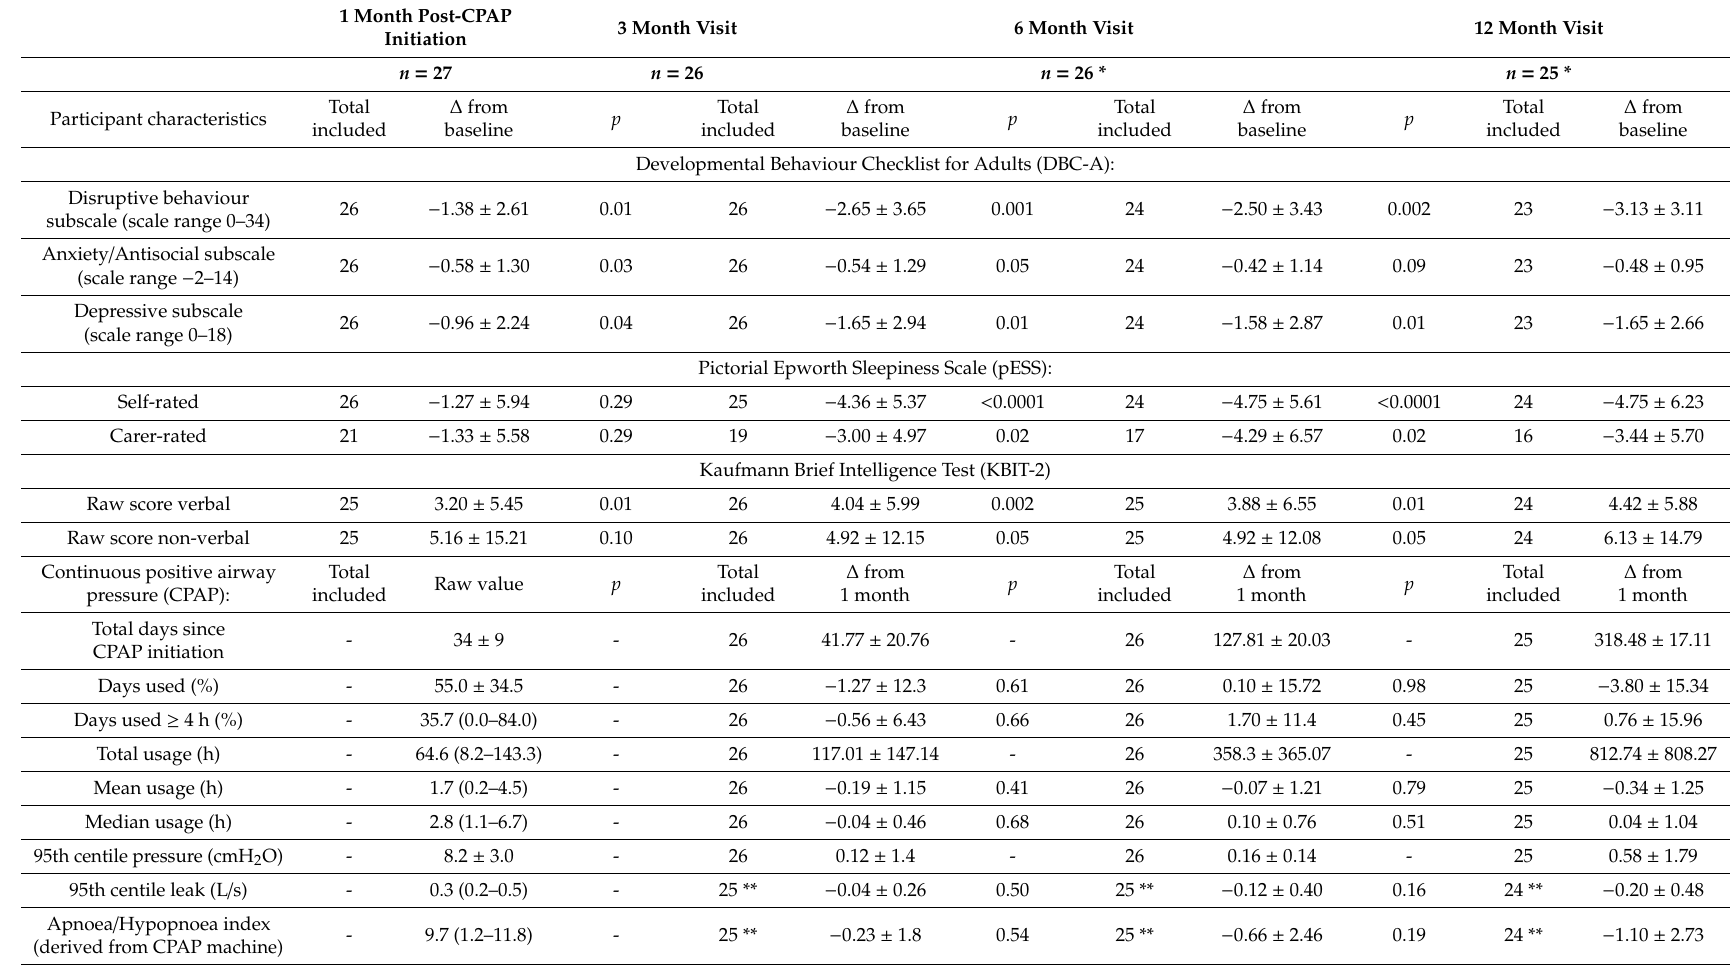
Table 3. Change ( ∆ ) from baseline in whole group at 1, 3, 6, and 12 months on CPAP (mean ± SD or median (IQR) as